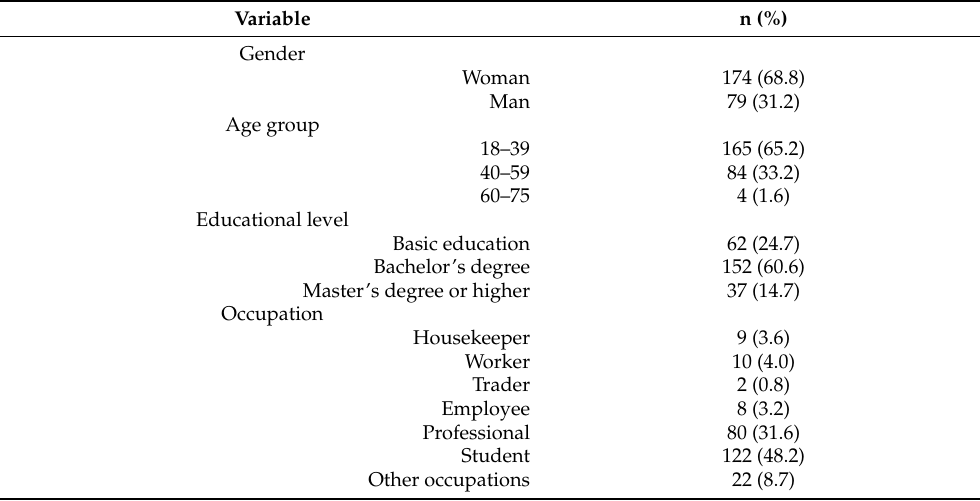
Table 1. Sociodemographic data of the survivors (n =